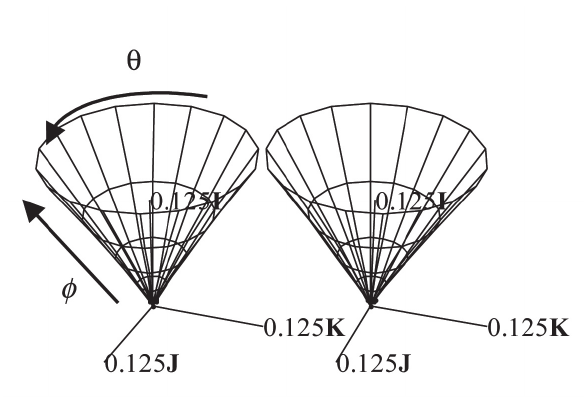
Figure 1 : The surface of tilted powers in symmetric dioptric power space for a thin lens of scalar power ( 1 0 ) , or 1 D in conventional terms, I D or F 0 = 0 1 is represented by means of a stereo-pair. Readers should fixate on a point in front of the plane of the paper to see the 3-dimensional percept. The lens, in air ( n* = 1), has refractive index 1.5. The surface is described as a pseudo-cone 2 and here consists of six closed curves (or circles) of constant tilt angle φ as well as curves (the generators of the pseudo-cone) of constant tilt axis θ . In this surface, for each of the closed curves the tilt axis increases from 0 to 180 0 in 10 0 intervals ( φ constant) while for each genera-